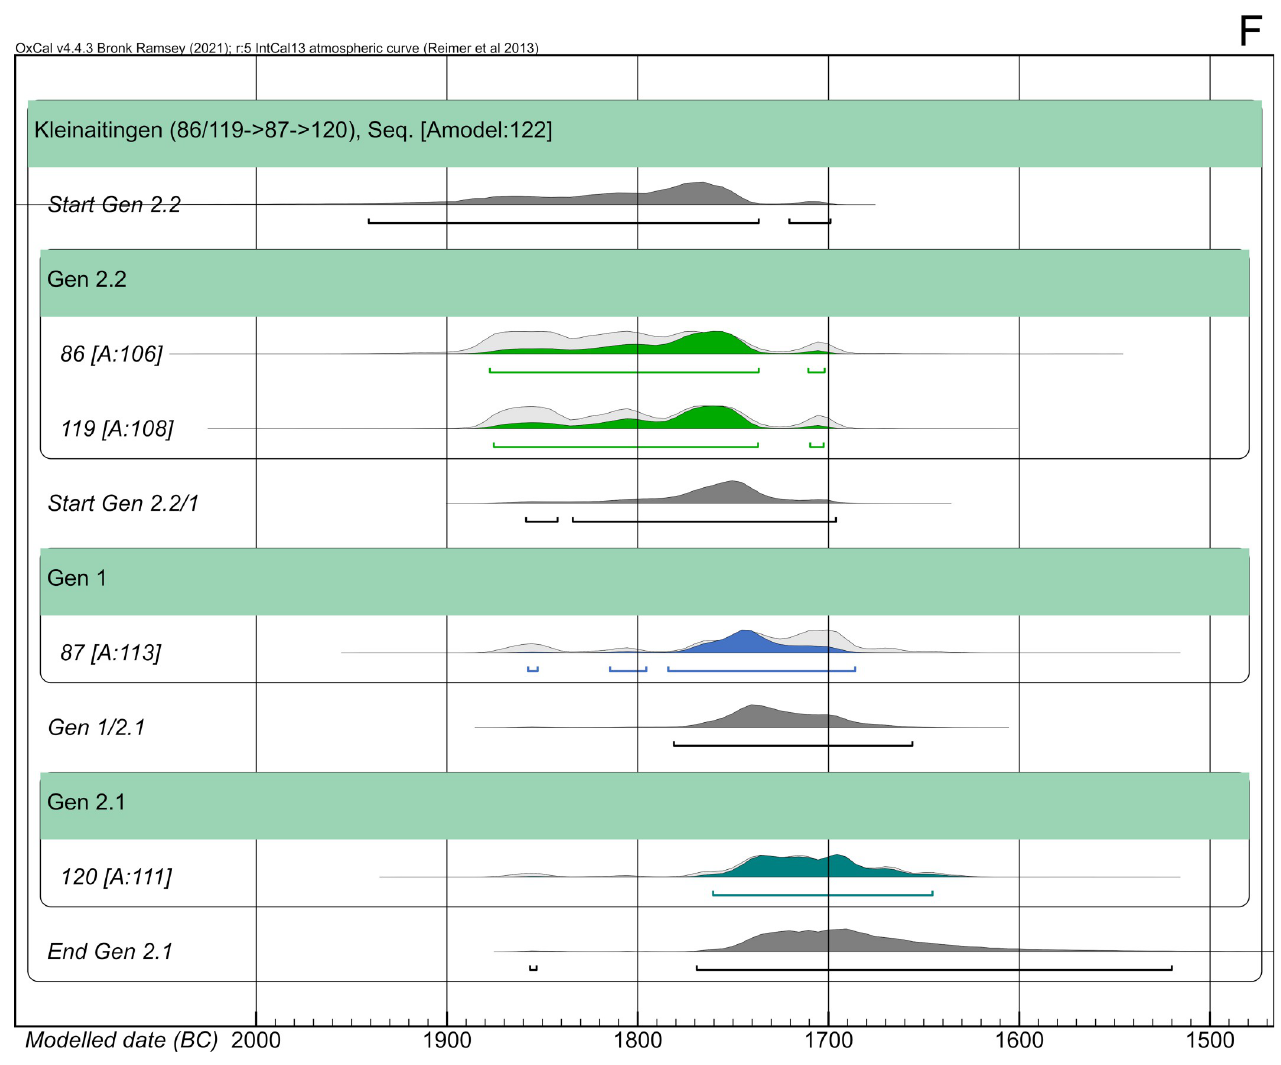
Fig 24. Results of Bayesian modelling of the entire pedigree of AITI. The process was run by directly sequencing the individuals in their proposed chronological order of death without intervals in between (see S8 Table Sheet